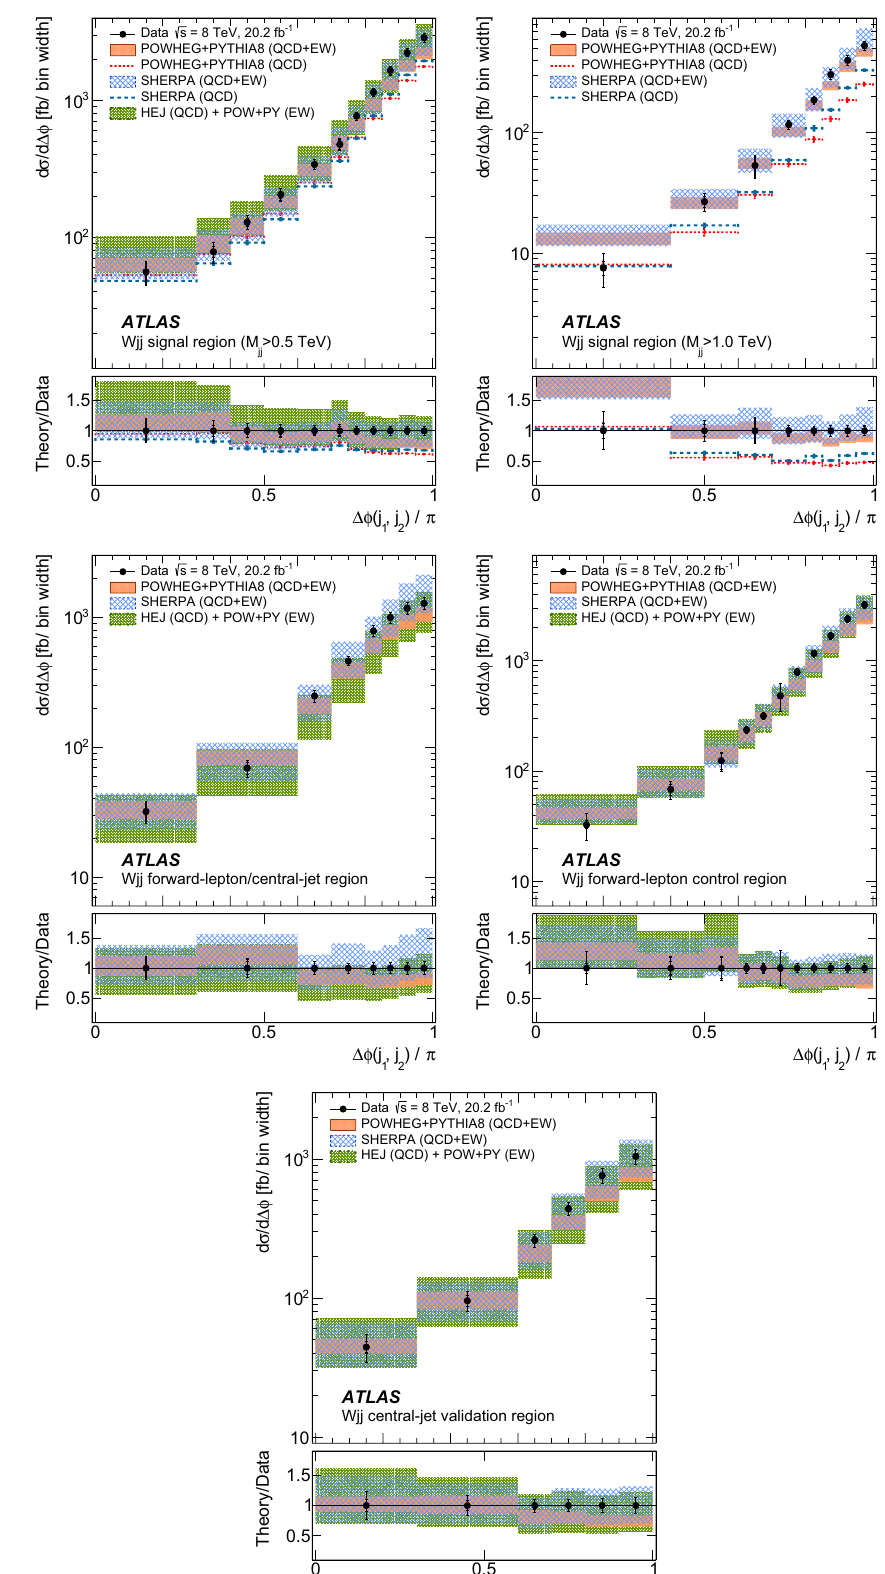
h d t w i n b i / [f b